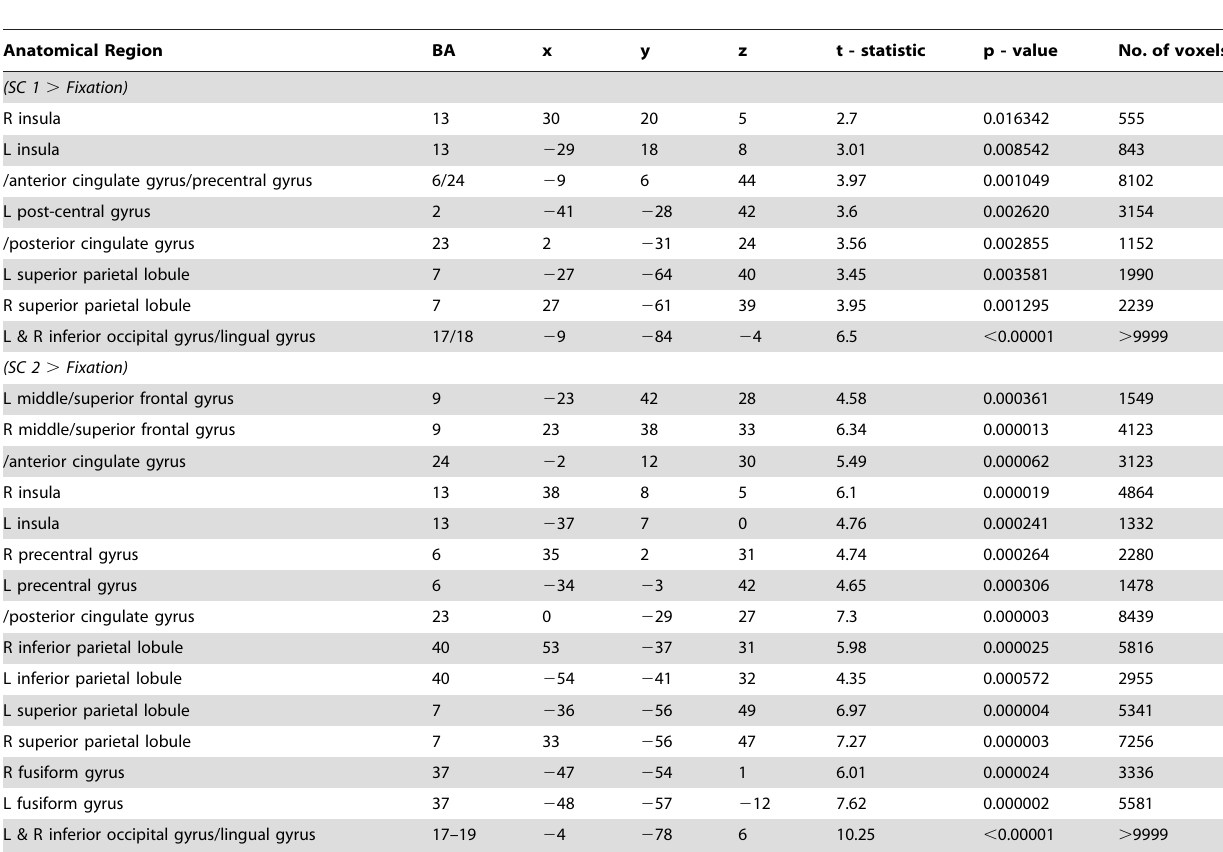
Table 2. fMRI results for the contrasts showing block-onset and block-offset predictors.